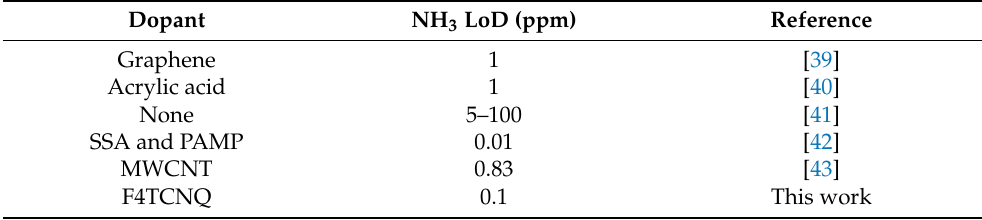
Table 1. Performance of various PANI based devices regarding ammonia